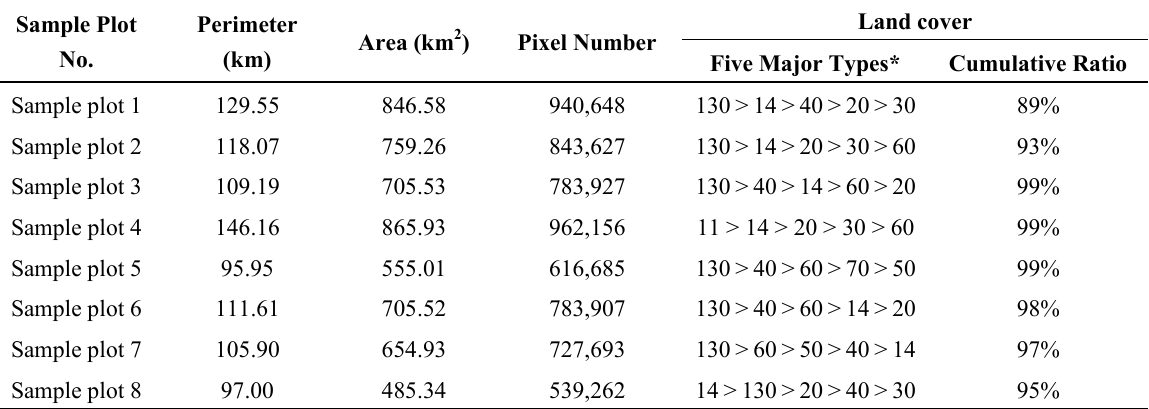
Table 2. Size and land cover structure of the selected sample